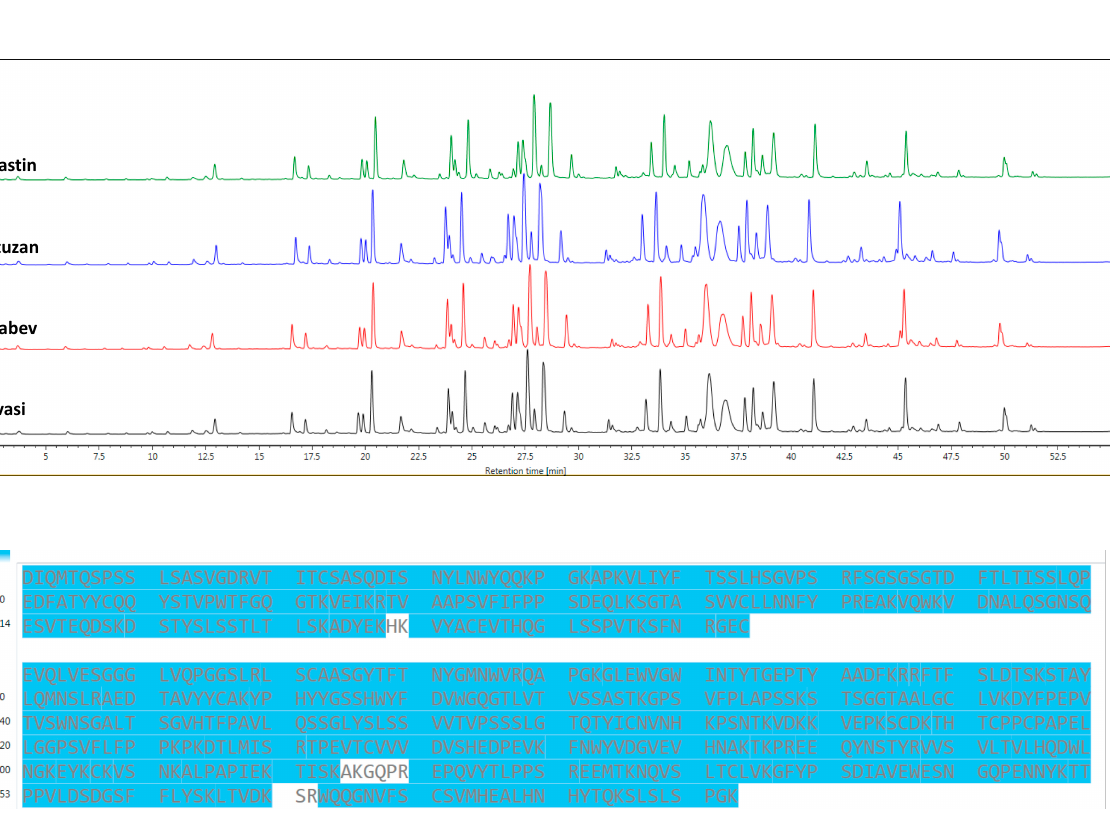
Figure 3. Peptide mapping analysis of the samples. ( A ) Comparison of peptide profiles of samples by overlaying TIC chromatograms of tryptic peptides. ( B ) A representative coverage map of ALT indicating 99% coverage. The blue highlighting indicates the identified sequences.